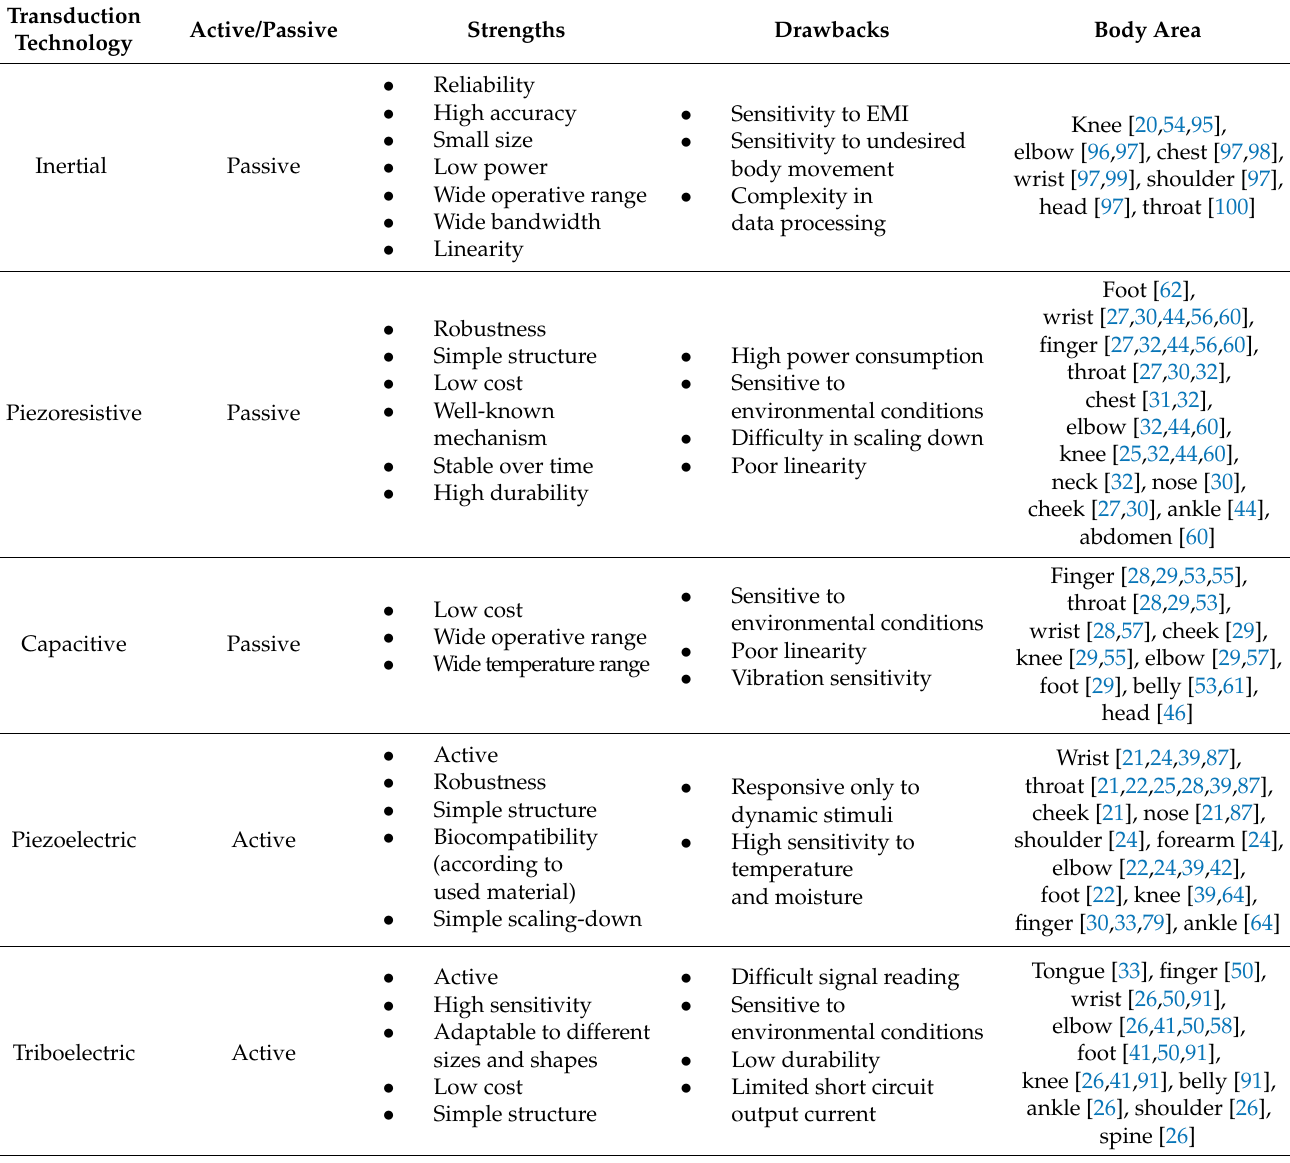
Table 3. Comparison of the main transduction technologies used in wearable systems to monitor sports and rehabilitation